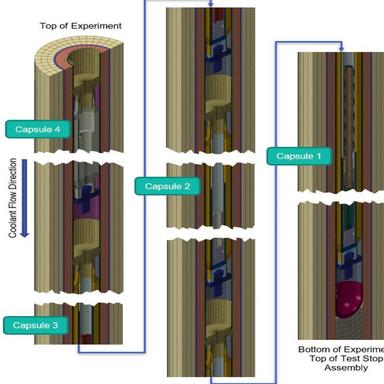
Shows axial cross section views of the IMPACT capsules in 3D modeled in ABAQUS.